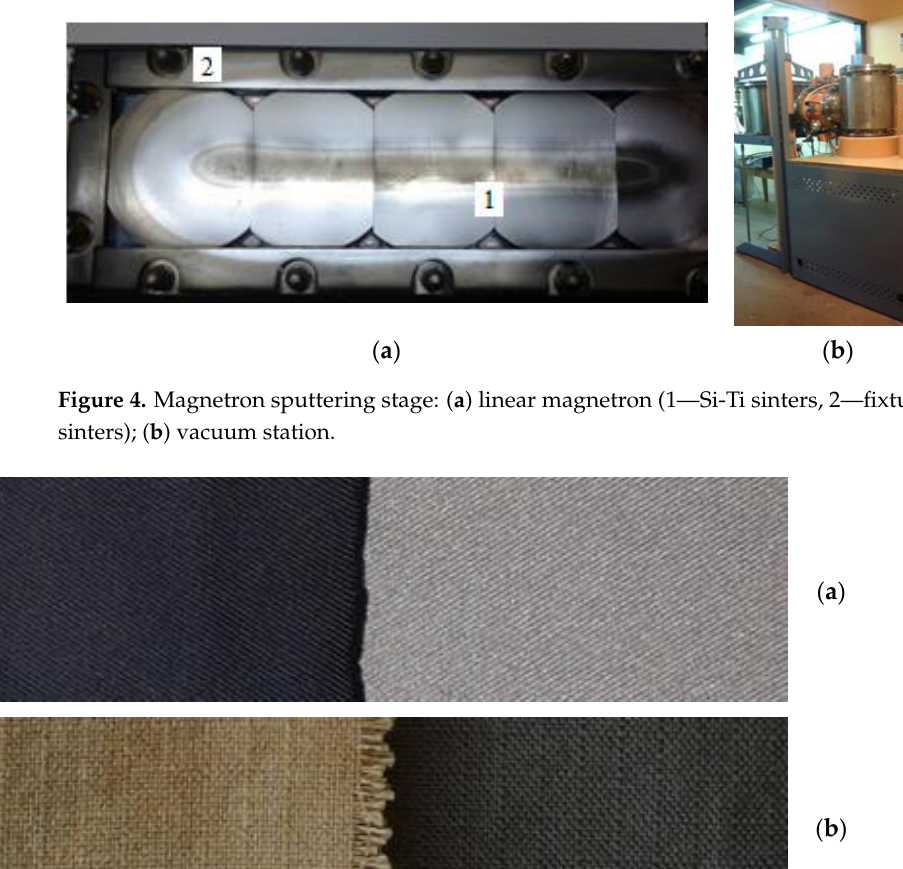
Figure 5. Tested samples: ( a ) PROTON: without coating (left ), with Ti-Si coating ( right ), ( b ) NATAN: without coating ( left ), with Ti-Si coating ( right ).